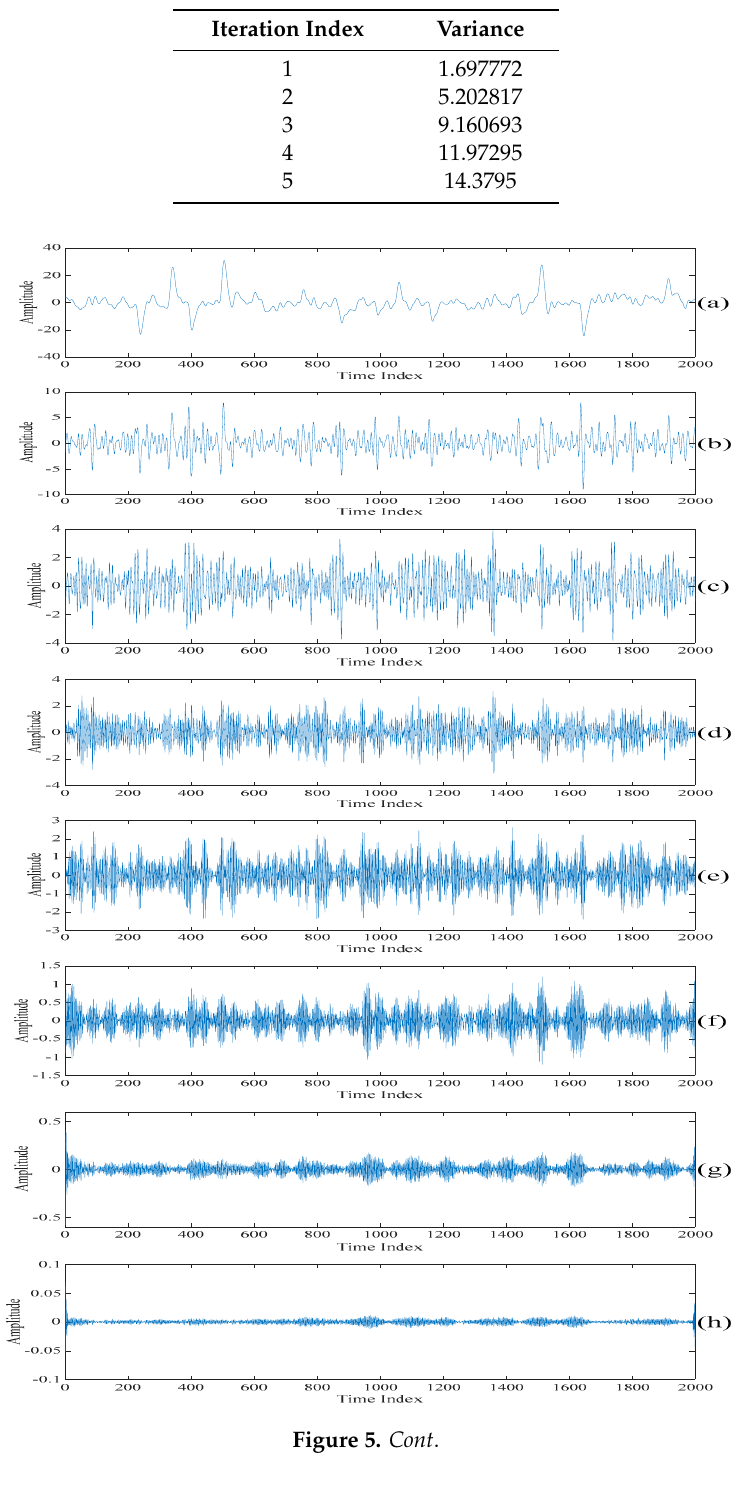
Table 2. The variances of the 2 n th scales of the electroencephalogram under the unit energy normalization.